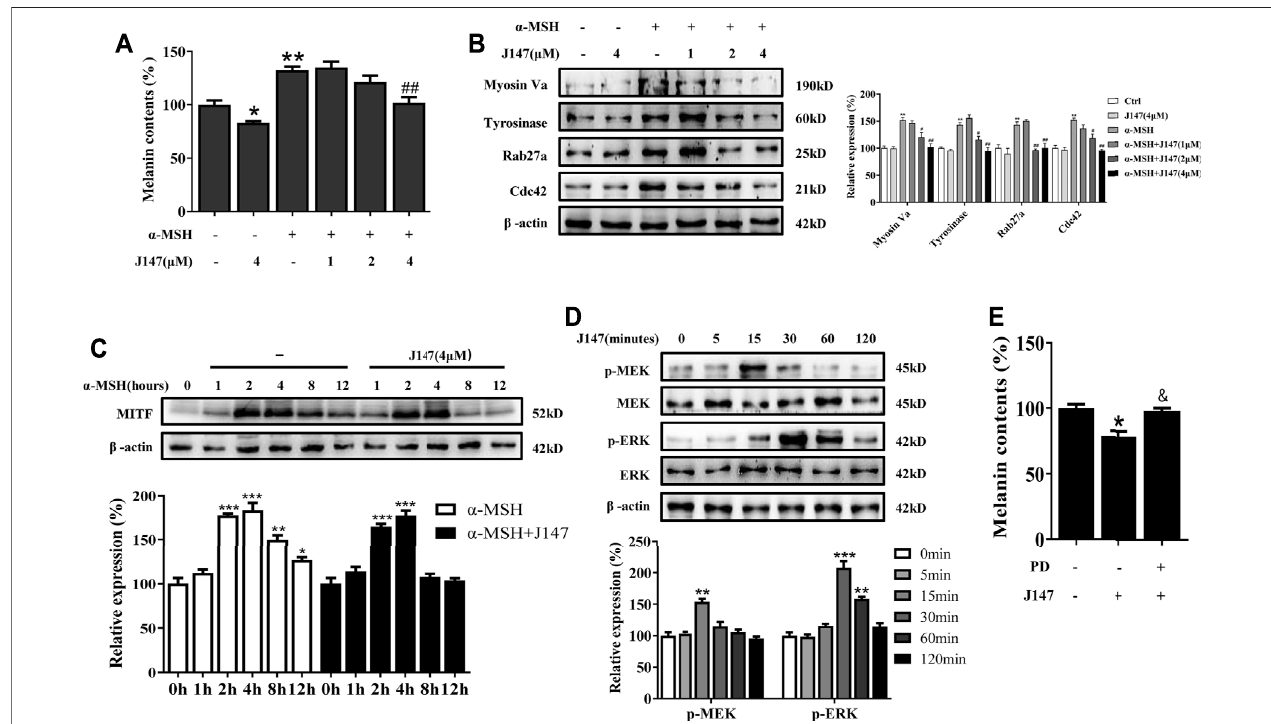
FIGURE 6 | Effect of J147 on melanogenesis in human melanocytes. (A) Human melanocytes were treated with J147 for 48 h and melanin contents were measured as described in methods. (B) Human melanocytes were treated with J147 for 48 h and the expression of Myosin Va, tyrosinase, Cdc42 and Rab27a were measuredusingwestern-blot asdescribedinmethods. (C) Humanmelanocytesweretreatedwith α -MSH(60 nM)inthepresenceorabsenceofJ147fordifferenttimes and western blot was then applied to detect MITF protein levels. (D) Human melanocytes were treated with J147 (4 μ M) for the indicated time period (0 – 120 min), andthephosphorylationofMEKandERKweremeasuredbywesternblot. (E) Humanmelanocyteswerepretreatedornotwith10 μ MPD98059(theinhibitorofERK)for 1 h before J147 was applied for 48 h. Melanin contents were measured as described in methods. * p < 0.05, ** p < 0.01, *** p < 0.001 vs. non-treated cells. # p < 0.05, ## p < 0.01 vs. α -MSH-treated cells. & p < 0.05 vs. J147-treated